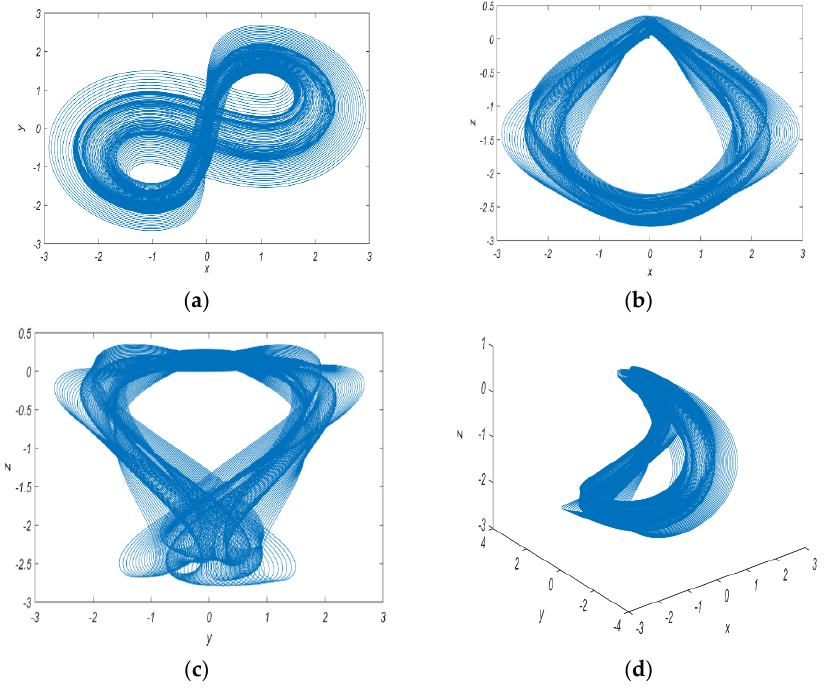
Figure 1. Phase portraits of the hidden chaotic attractors obtained from the system (5): ( a ) x-y projection; ( b ) x-z projection; ( c ) y-z projection; ( d ) x-y-z 3D